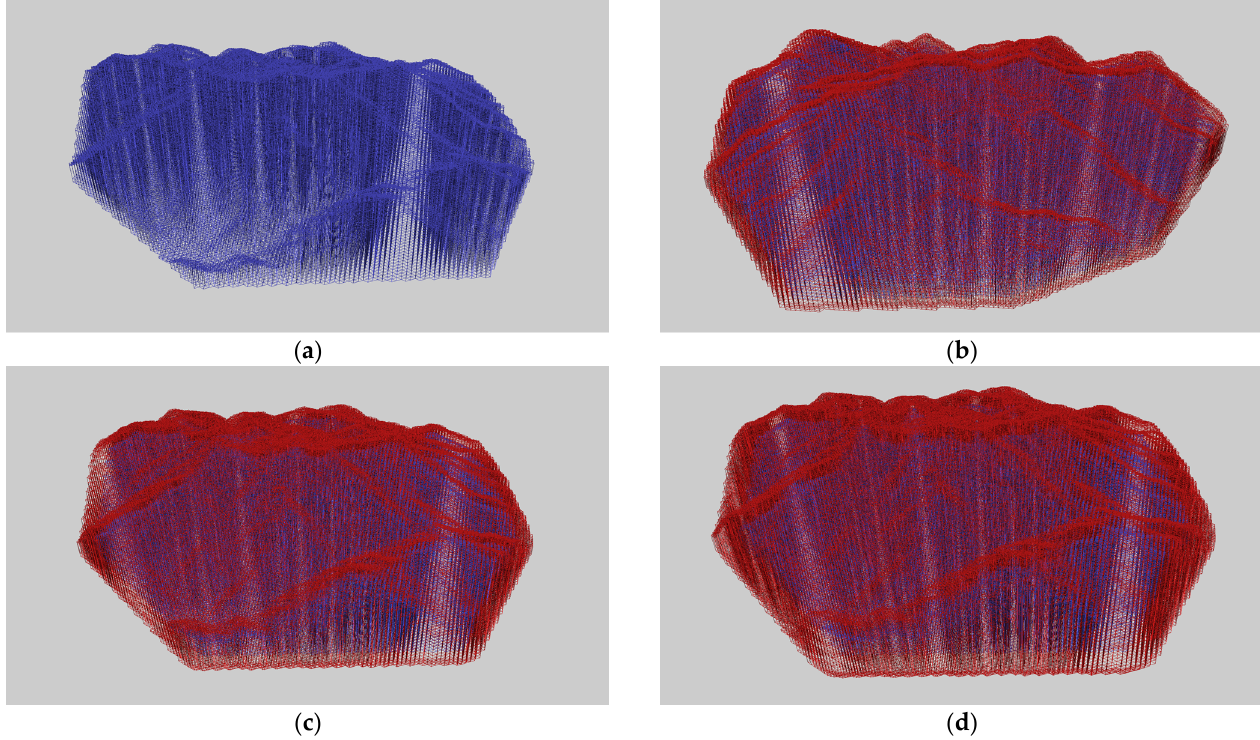
Figure 8. Wireframe models of the target area ( a ) and its buffers with 40 ( b ), 120 ( c ), and 200 m ( d ) radii at the sphere grid level of 18. Cells marked as the target area are shown in blue, and cells marked as the buffer are shown in red.